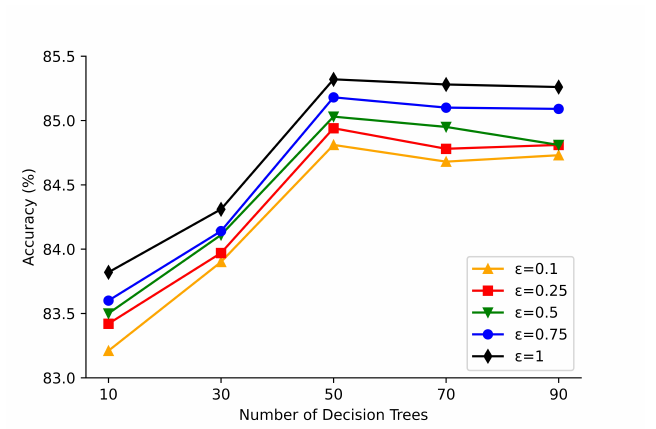
Figure 4. Variation of classification accuracy with the number of decision trees for the Adult